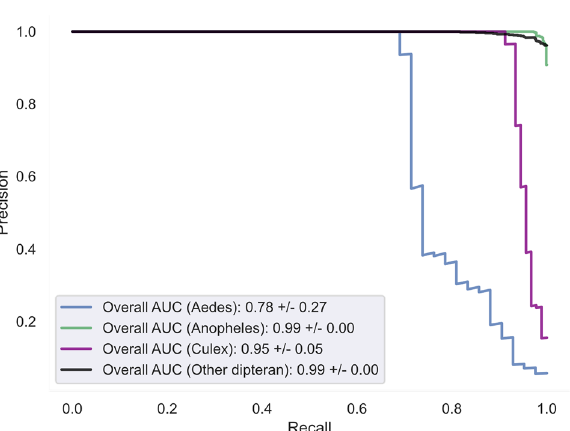
Figure 7. Precision-Recall curve quantifying the performance of the semi-supervised classifier when trained on the entire dataset. Precision-Recall curves illustrate the ability of our deep learning model to balance the identification of true positive sequences while minimizing the number of false identifications (precision) and false negatives